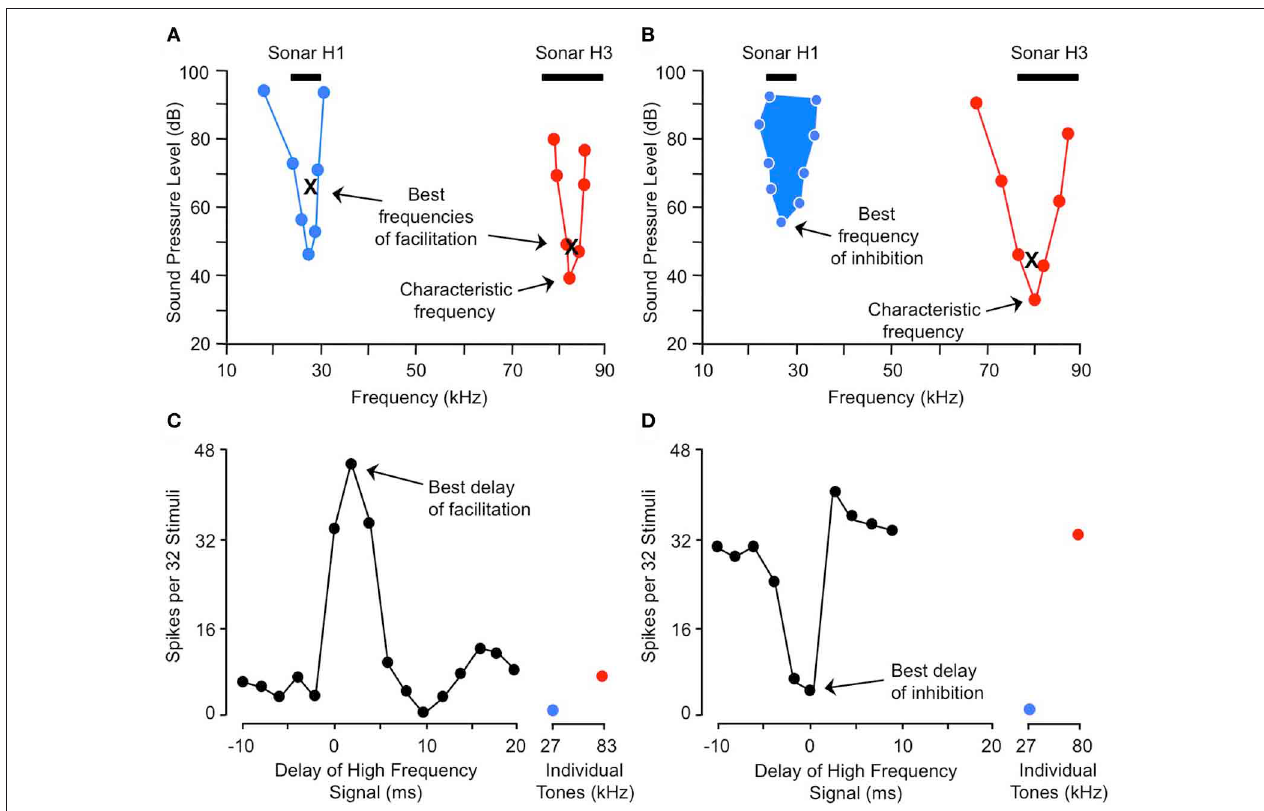
FIGURE 2 | Spectral and temporal tuning of combination sensitivity in the mustached bat’s IC. Figure shows responses of a facilitated neuron (A and C) and an inhibited neuron (B and D) . (A) Facilitation frequency tuning curves for high-frequency ( red ) and low-frequency ( blue ) tone bursts. These curves were obtained by fixing the frequency and level of one tone burst (X) while varying the frequency and level of a second tone burst in the other frequency band, in order to obtain threshold facilitative responses. Facilitation was defined as a response to the combination stimulus that was 20% greater than the sum of responses to the two stimuli presented separately. The high-frequency tone burst was presented at a delay corresponding to the neuron’s best delay of facilitation (shown in C ). (B) Excitatory ( red ) and inhibitory ( filled blue ) tuning of neuron showing combination-sensitive inhibition. The low-frequency inhibitory tuning curve was obtained by presenting a characteristic frequency tone burst at a fixed level (X), then